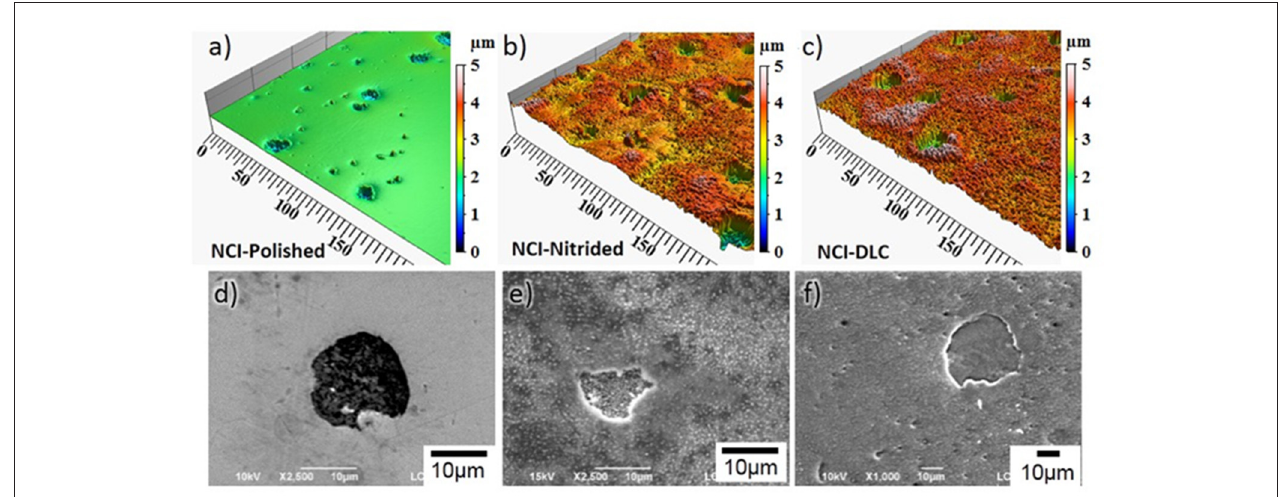
FIGURE 4 | Topography evolution with WLI and SEM analyzes for Gray Cast Iron (GCI), polished (a,d) , nitrided (b,e) and with DLC (c,f) (Giacomelli et al., 2017).